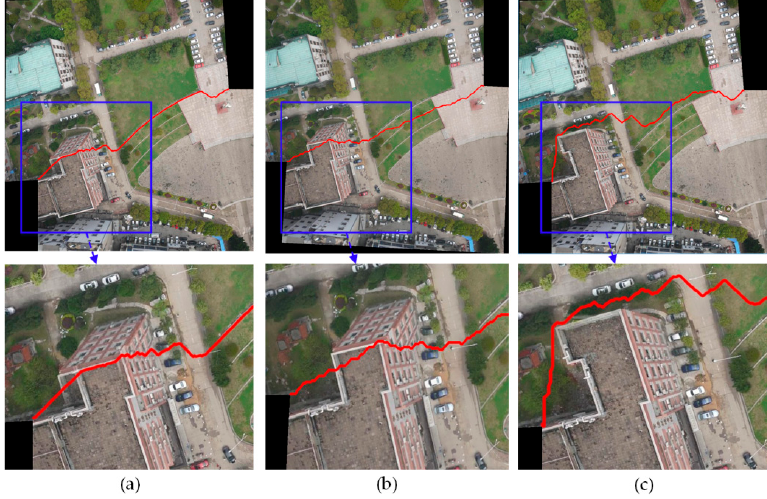
Figure 11. The seam lines of different searching algorithms for Figure 7b: ( a ) Duplaquet algorithm; ( b ) OpenCV algorithm; ( c ) Our algorithm.